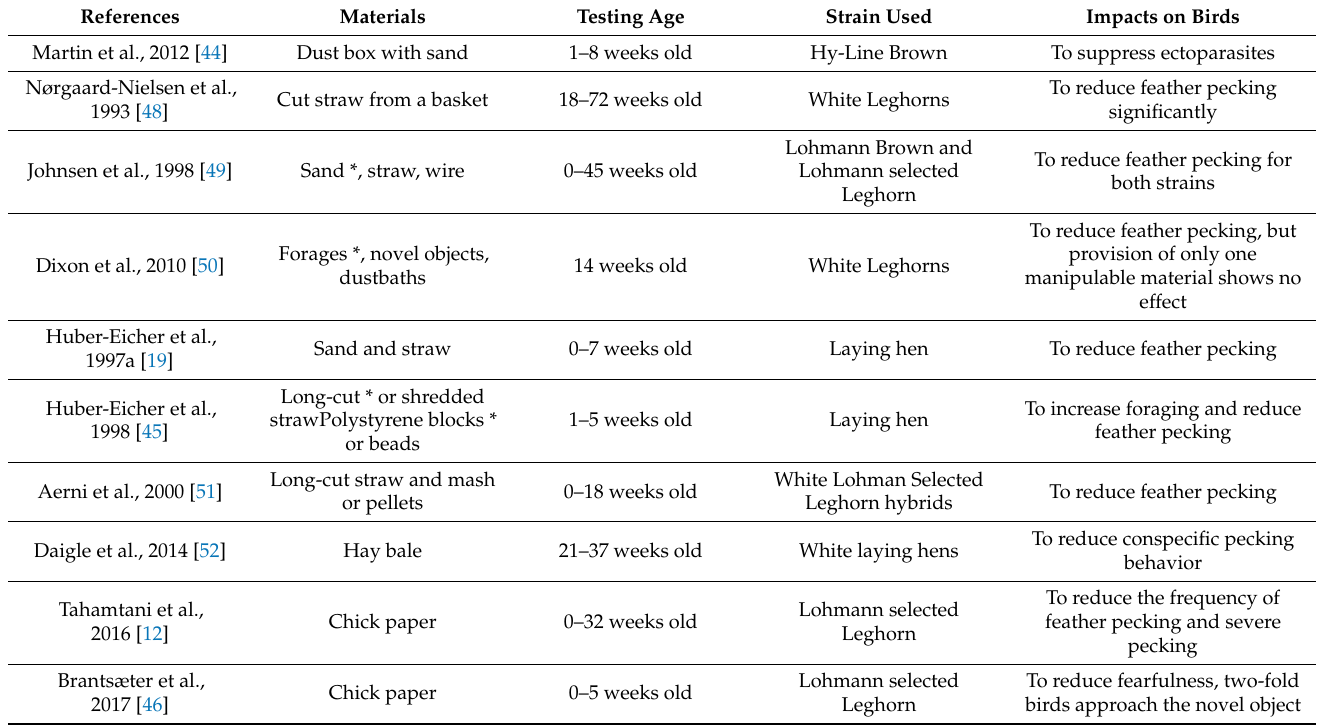
Table 1. Litter materials designed for layers use in different